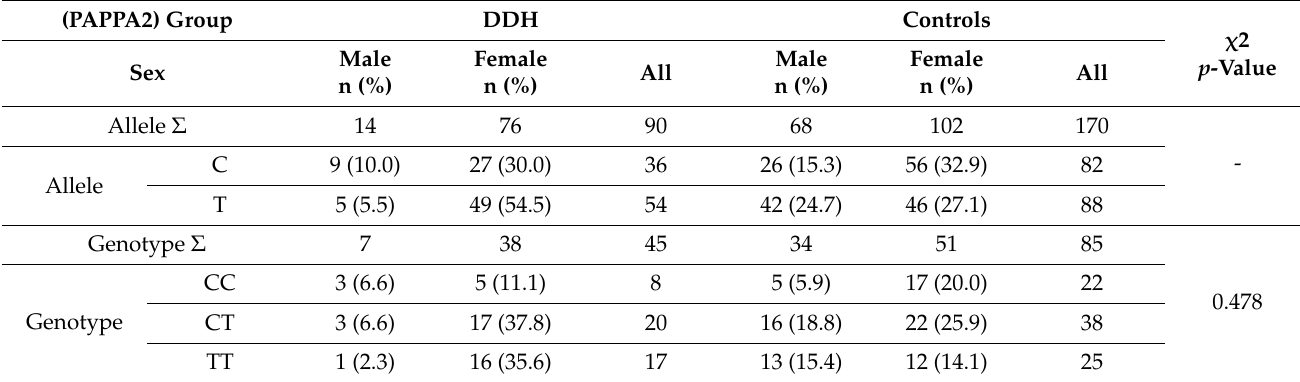
Table 4. Distribution of alleles and genotypes in association to rs726252 in the PAPPA2 gene and DDH occurrence. (PAPPA2)